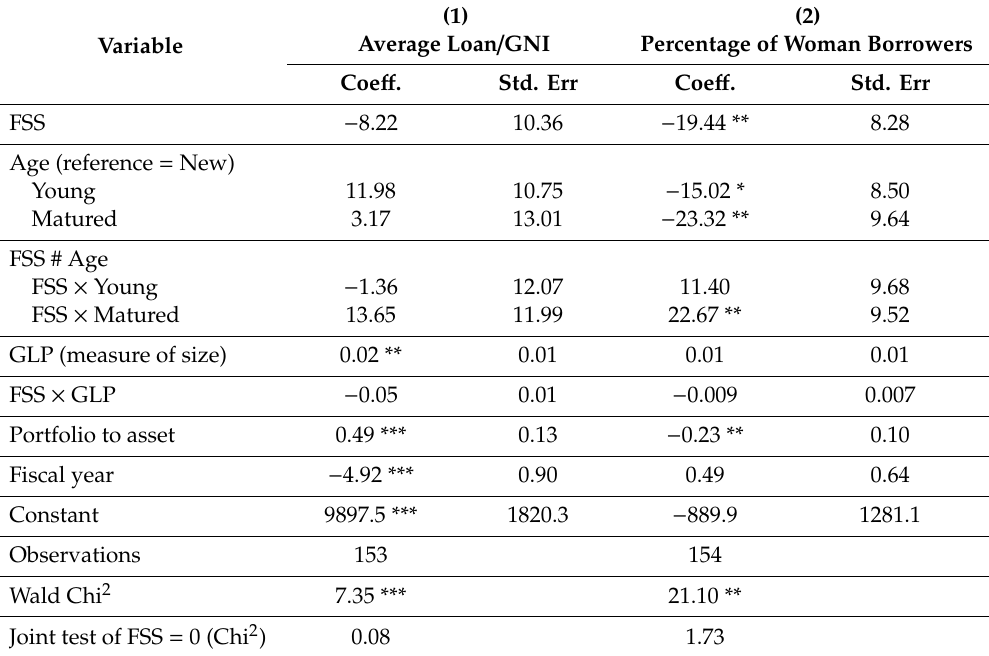
Table 4. Outreach depth and financial sustainability: test for mission